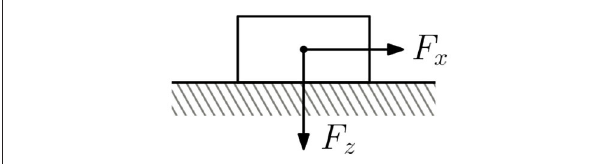
FIGURE 1 | Static friction model. The intrinsic coefficient of friction in the contact is µ 0 . The y -axis points out of the